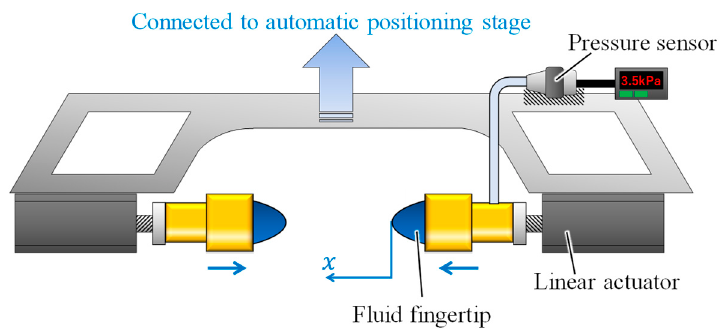
Figure 8. Experimental setup for grasping test